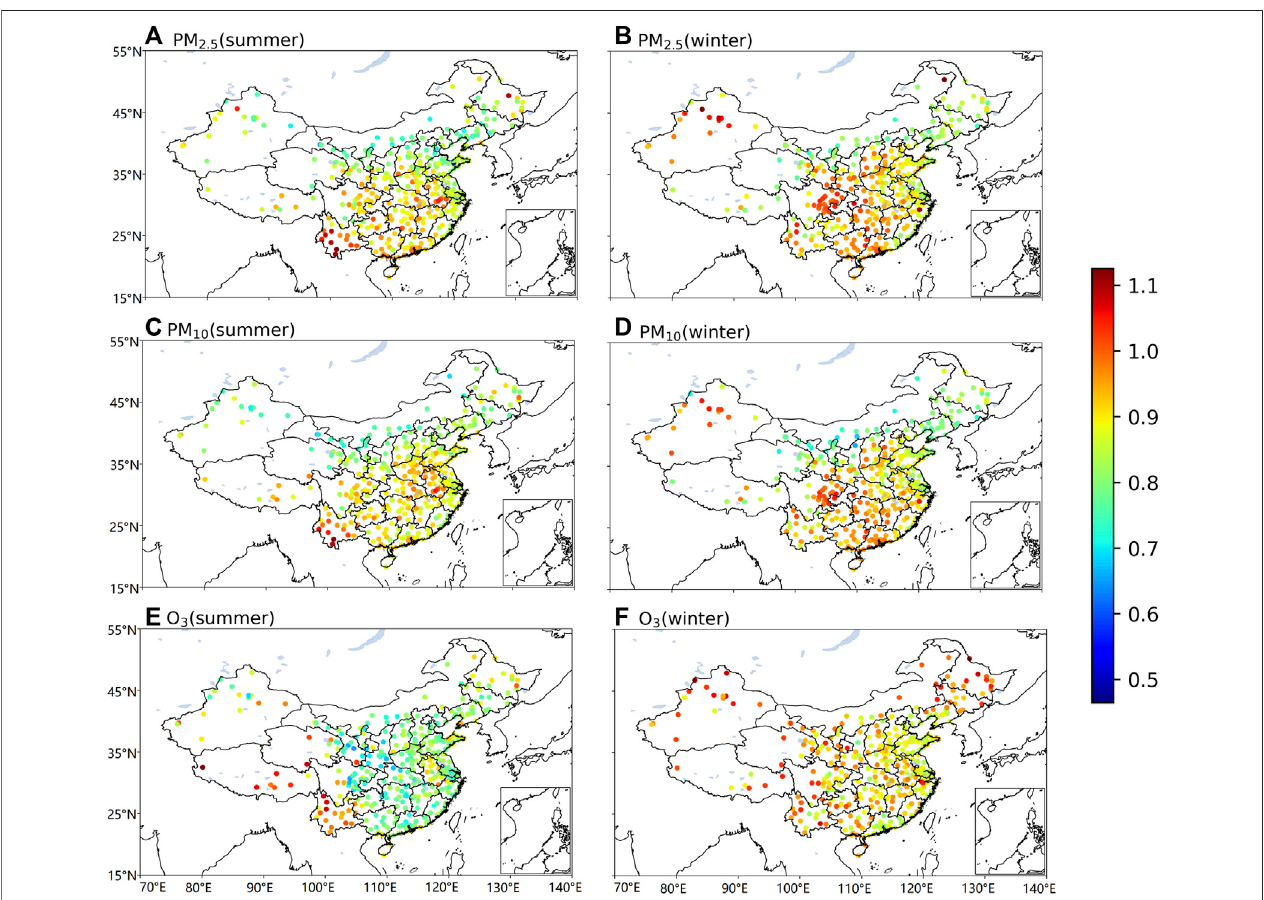
FIGURE5| (coloronline)SpatialdistributionsoftheDFAscaleexponent α for (A) PM 2.5 , (C) PM 10 ,and (E) O 3 insummer. (B) , (D) ,and (F) aresameas (A) , (C) ,and (D) but in winter.